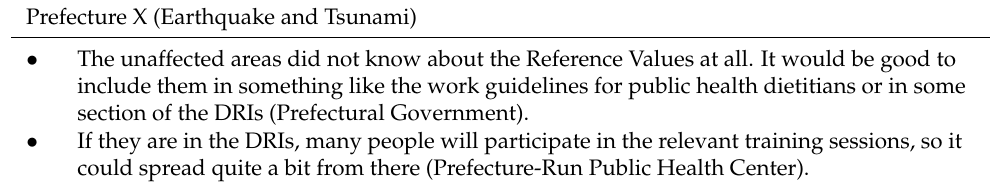
Table 13. What is needed for the Reference Values to become more widely adopted? (Q9). Prefecture X (Earthquake and